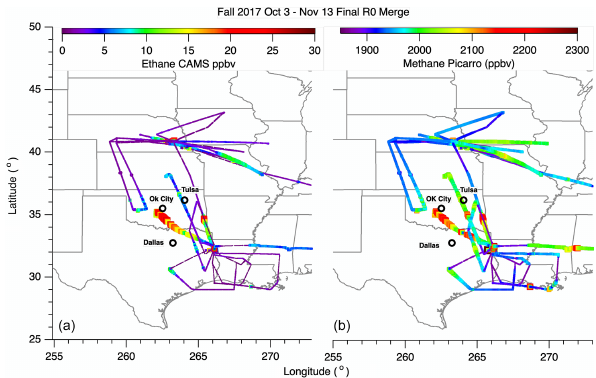
Figure 10. Simultaneous ethane (a) and methane (b) over the south- east. The ethane measurements are from the CAMS-2 instrument, while methane measurements were acquired from a PICARRO in- strument onboard the B200 aircraft.